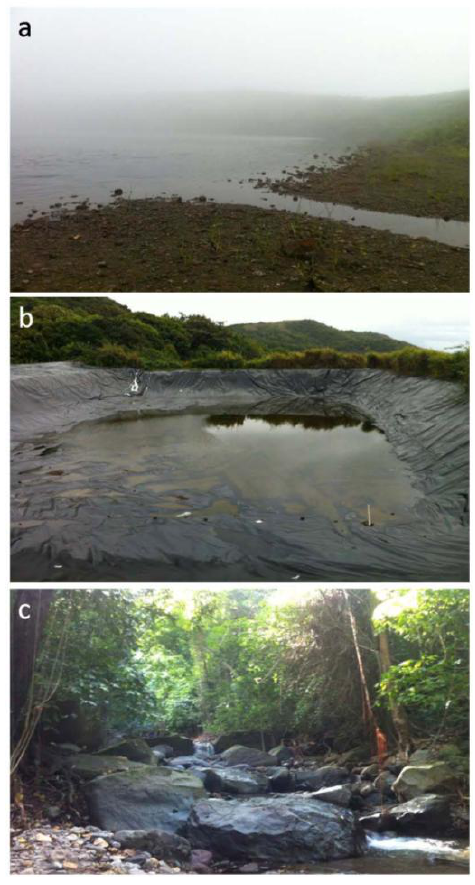
Figure 2. Sample collections sites: ( a ) a pond; ( b ) a water dam; and ( c ) a